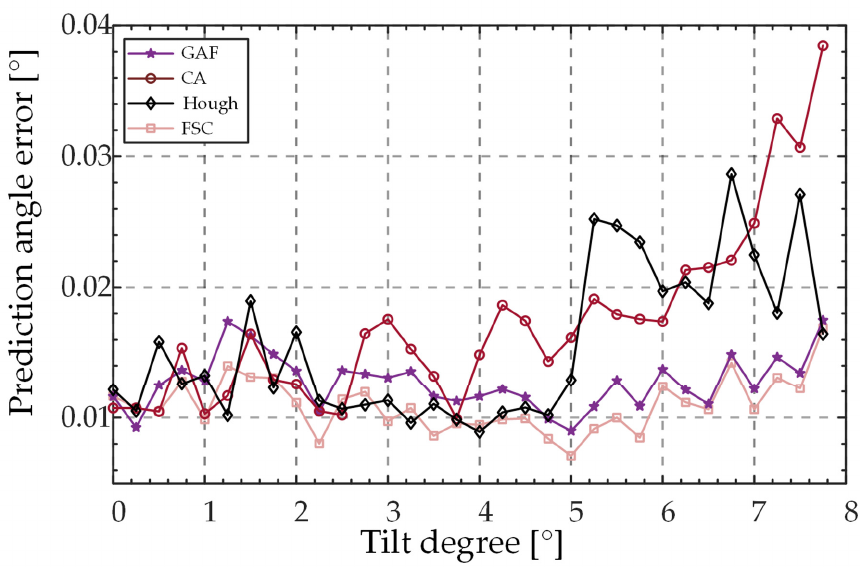
Figure 11. Variation in prediction error θ of different algorithms as a function of θ .